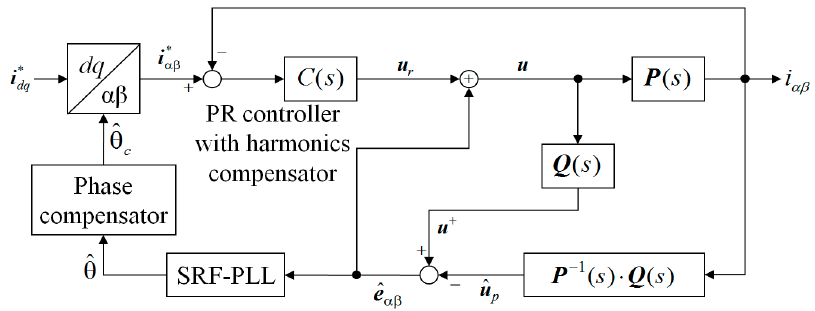
Figure 2. Overall block diagram for the proposed voltage-sensorless control scheme.